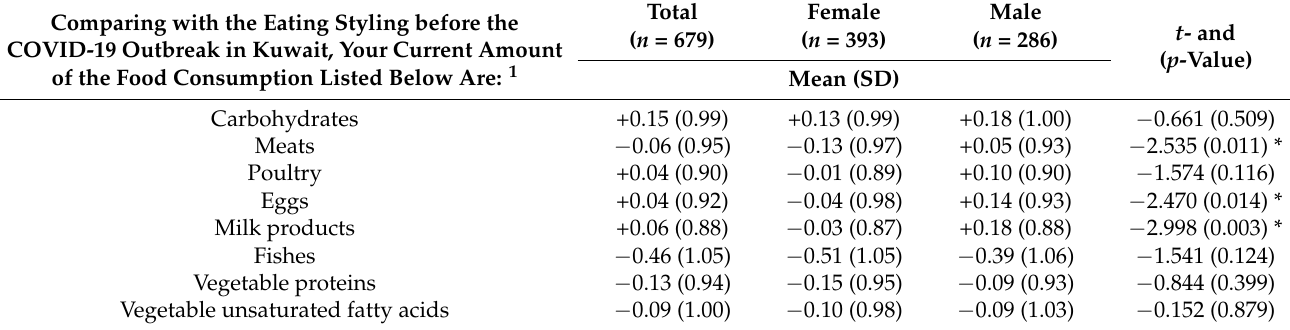
Table 1. Comparisons of food consumption between before and during the COVID-19 outbreak. Comparing with the Eating Styling before the COVID-19 Outbreak in Kuwait, Your Current Amount of the Food Consumption Listed Below Are: